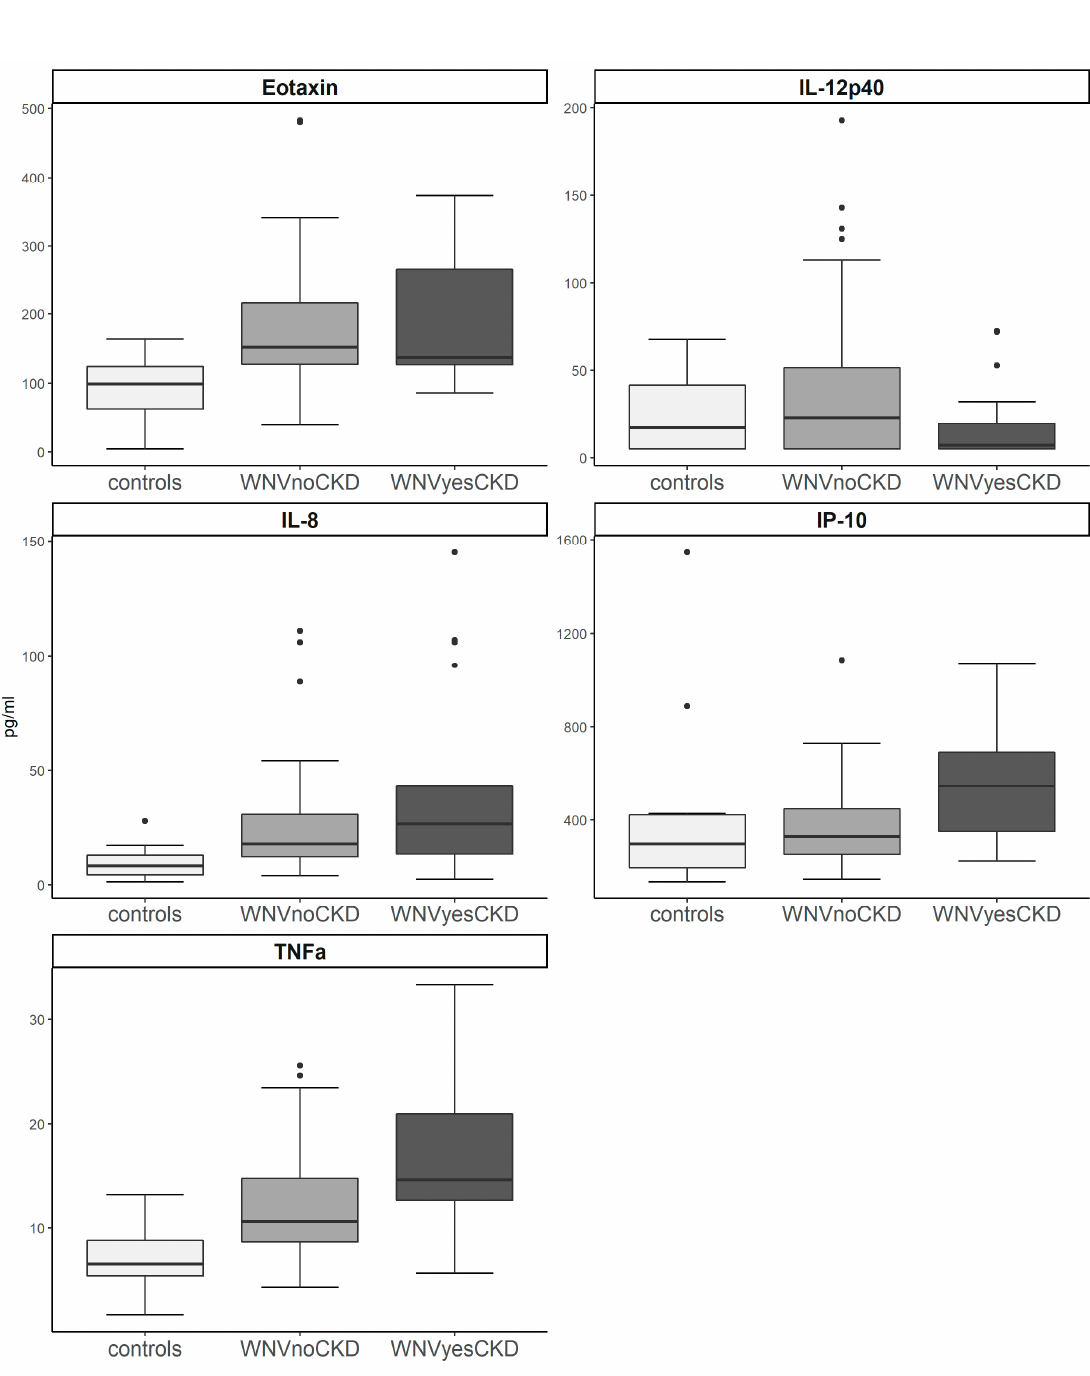
Figure 1. Cytokine values per WNV exposure group. Serum samples were drawn from study participants at last time points of data collection and were analyzed using a Luminex ® IS 100 platform (Austin, TX, USA) to detect 26 different cytokines. Of all 26 cytokines, five were found to have a statistically meaningful difference between two of the three possible groups (statistical significance was reduced to 0.0019 due to multiple comparisons). Eotaxin and IL-12p40 were both found to have meaningful differences between the controls and those with history of WNV without CKD ( p -value = 0.0013 and 0.0002, respectively). IL-8 and TNF α were both found to have meaningful differences between controls and individuals with history of WNV and subsequent development of CKD ( p -value < 0.0001, both). Lastly, IP-10 was found to be significantly higher in individuals with CKD and history of WNV infection compared to those with history of WNV and no evidence of CKD ( p -value =